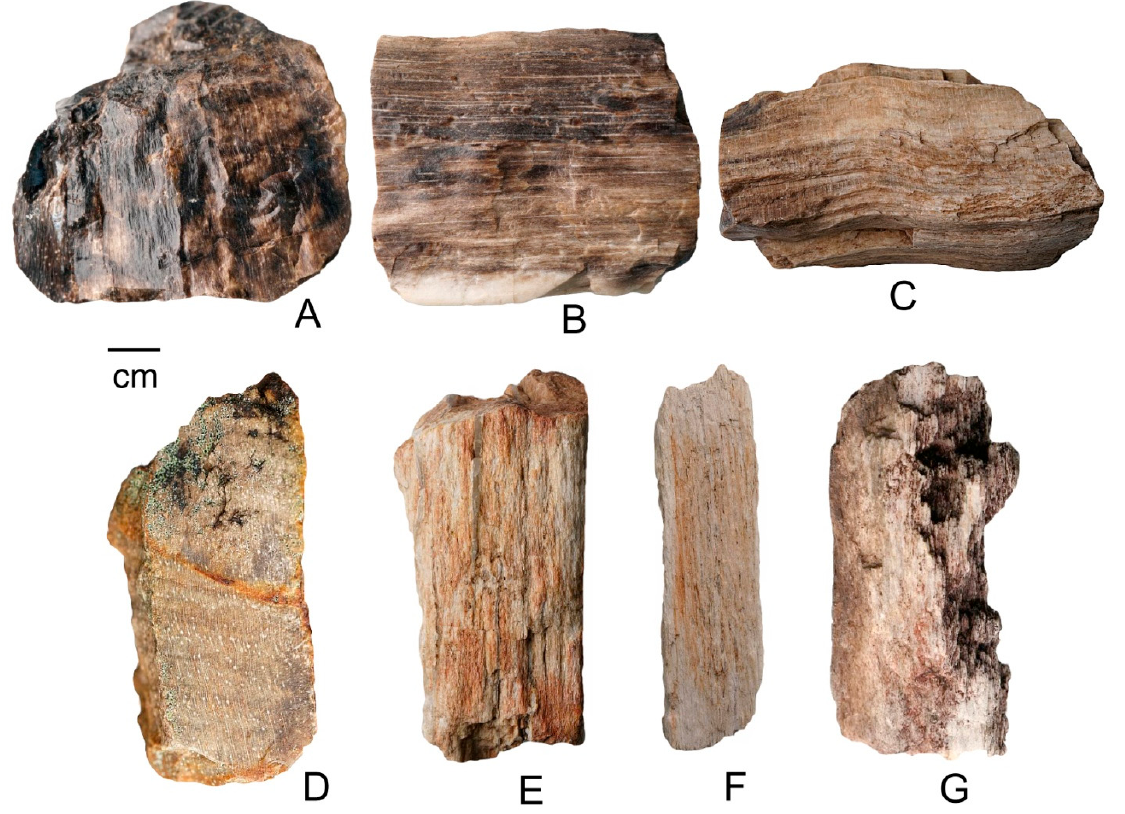
Figure 4. Examples of fossil wood specimens used in this study. ( A – D ) Las Crucitas locality; ( E – G ) Salitre locality. All specimens are tropical gymnosperms, except for ( D ), which is an angiosperm.